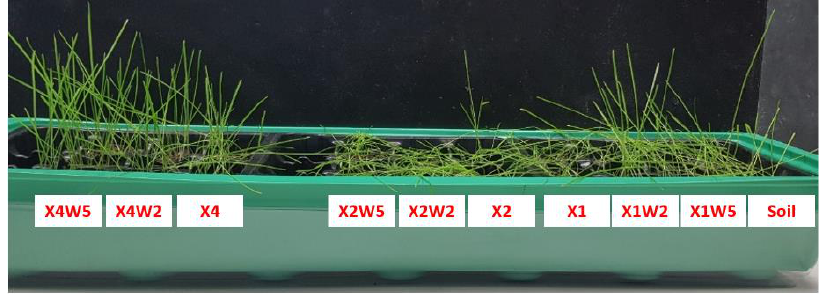
Figure 10. Images of the grass after 7 days of interruption of water supply.